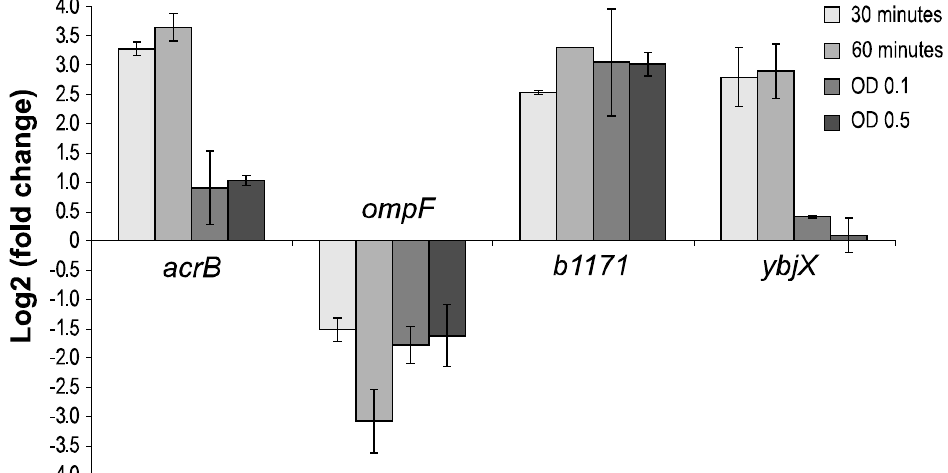
Figure 2. Real-time PCR results of Escherichia coli cells exposed to BC at 30 and 60 min, and at OD 0.1 and 0.5 after inoculation (equivalent to sampling points 1, 2, 3 and 4, respectively, shown in Figure 1). The expression is presented as log 2 of fold change compared to the reference gene, accD , and the control. The expression was based on 3 biological replicates.